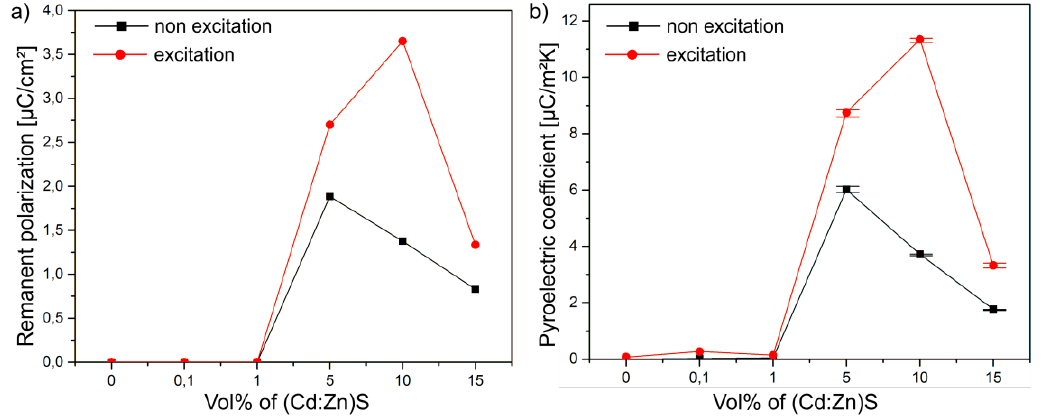
Figure 8. ( a ) Remanent polarization and ( b ) Pyroelectric coefficient of P(VDF-TrFE) composites as a function of the (Cd:Zn)S particle concentration polarized with and without photoexcitation.